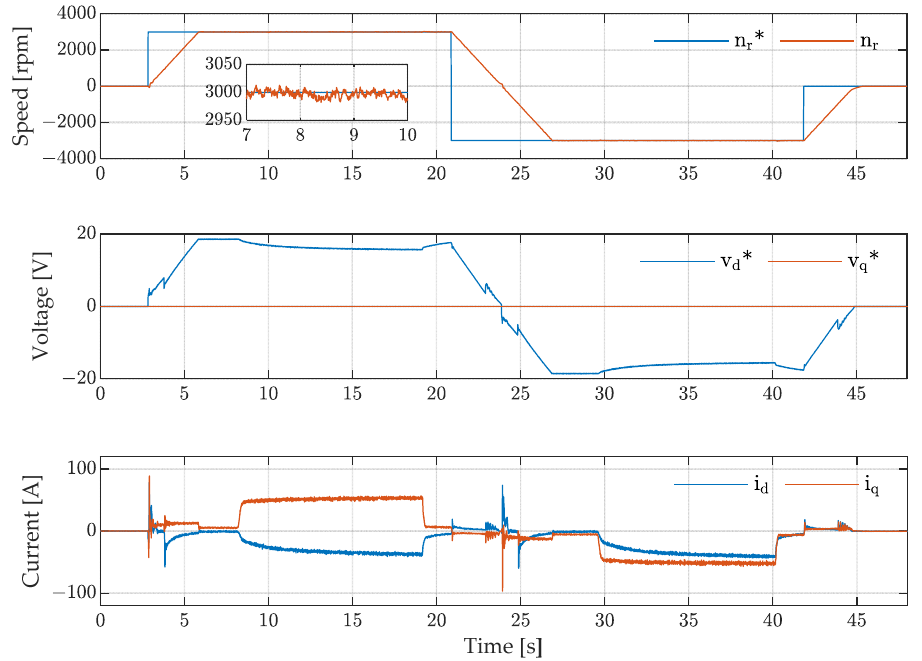
Figure 22. Ramp ‐ up and ramp ‐ down with the nominal reference speed and 75% load applied at steady ‐ state, with a required power factor of 1: speed, dq voltages, dq currents.